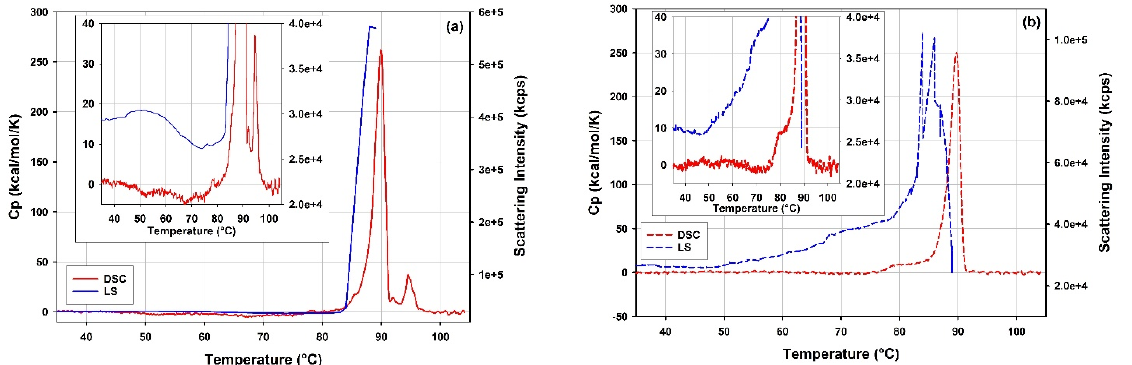
Figure 11. Overlay of the DSC and Light Scattering (LS) thermal ramp traces of ( a ) the full and ( b ) the empty rAAV5 samples. The inserts show the overlays in the temperature range preceding the main transition. The DSC data are corrected for the instrument blank and the baseline contribution and normalized by the VP protein content in the respective rAAV5 samples. The light scattering data from the thermal ramp DLS measurement is presented as derived count rate, DCR in kilocounts per second.